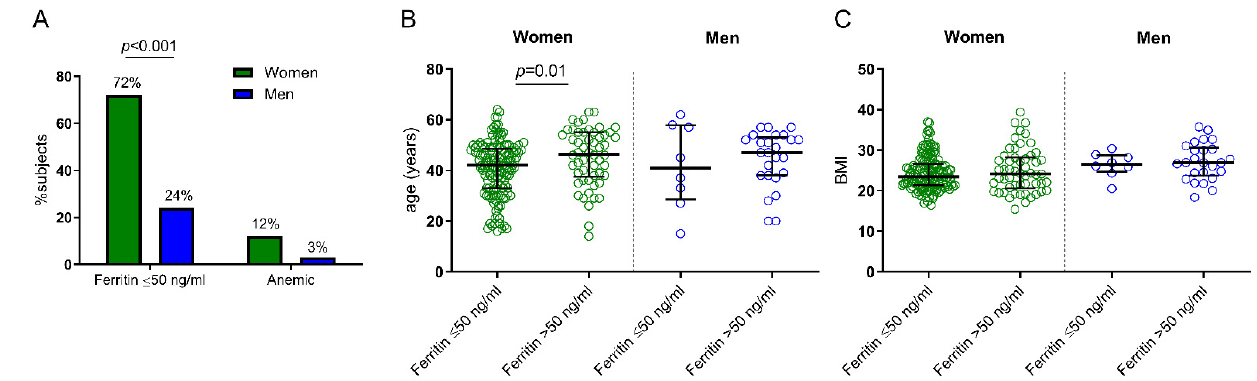
Figure 3. Iron deficiency and anemia frequency and differences in age and BMI depending on ferritin cut-off. Frequency of subjects with serum ferritin levels ≤ 50 ng/mL and with anemia in women and men ( A ); and differences in age ( B ) and BMI ( C ) depending on serum ferritin cut-off of 50 ng/mL in women and men. BMI: body mass index. Differences between categorical and continuous values were determined using the chi-square test and Mann–Whitney U-test, respectively. Only statistically significant differences with p -value < 0.05 are shown.